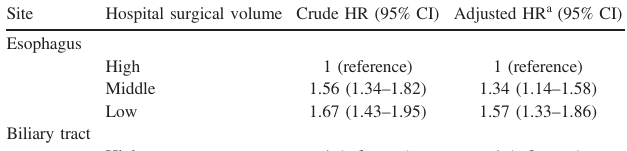
Table 4. Association between hospital surgical volume and 3- year mortality in esophageal, biliary tract, and pancre- atic cancer patients who received curative surgery, with and without adjustment for patient